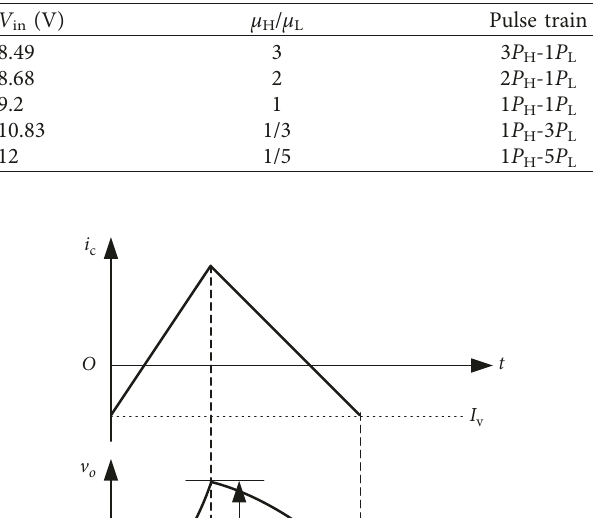
Table 2: Pulse train of the DCPT-controlled buck converter at different